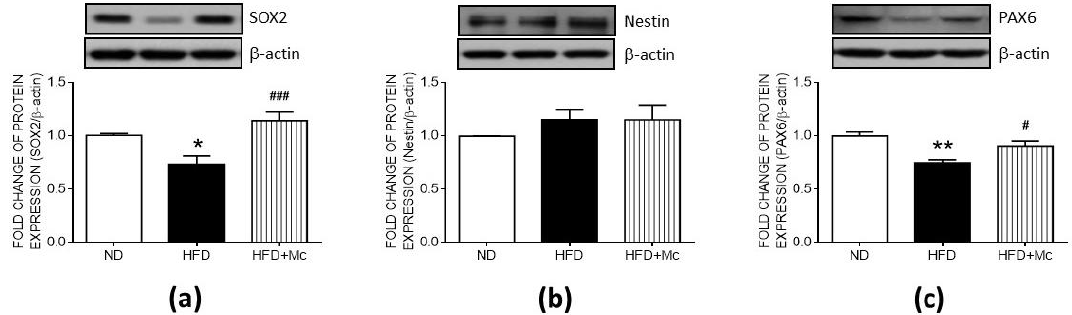
Figure 3. HDAC4 inhibition counteracted the suppression of markers of the hippocampal neural stem cells (NSCs) in the HFD group. The representative gel and densitometric analyses of ( a ) sex-determining region Y box 2 (SOX2); ( b ) Nestin; and ( c ) Paired Box 6 (PAX6) in the hippocampus of female offspring at 12 weeks old. * p < 0.05, ** p < 0.01 indicate significant differences from the ND group and # p < 0.05, ### p < 0.001 indicate significant differences from the HFD group using a post-hoc Tukey’s multiple range test . ND: n = 12; HFD: n = 12; HFD+Mc: n = 6. ND: female offspring exposed to a maternal normal diet; HFD: female offspring from maternal high-fructose diet; Mc-1568 (Mc), 5 μ M by icv infusion for 4 weeks. β -actin was used as an internal loading control.